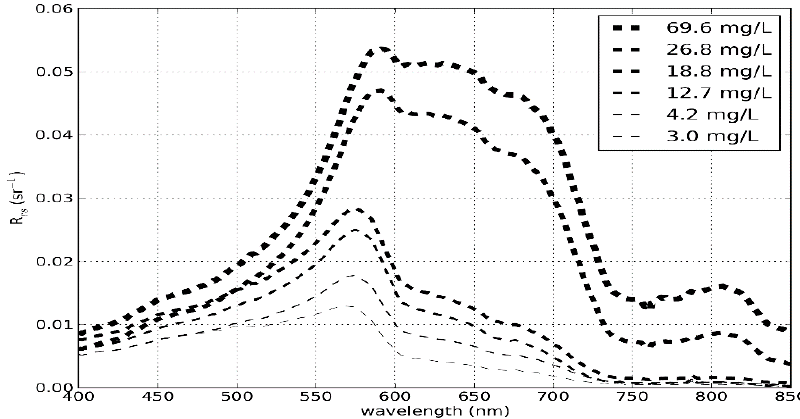
Figure 2. In situ DALEC spectral reflectance plots for different ranges of TSS